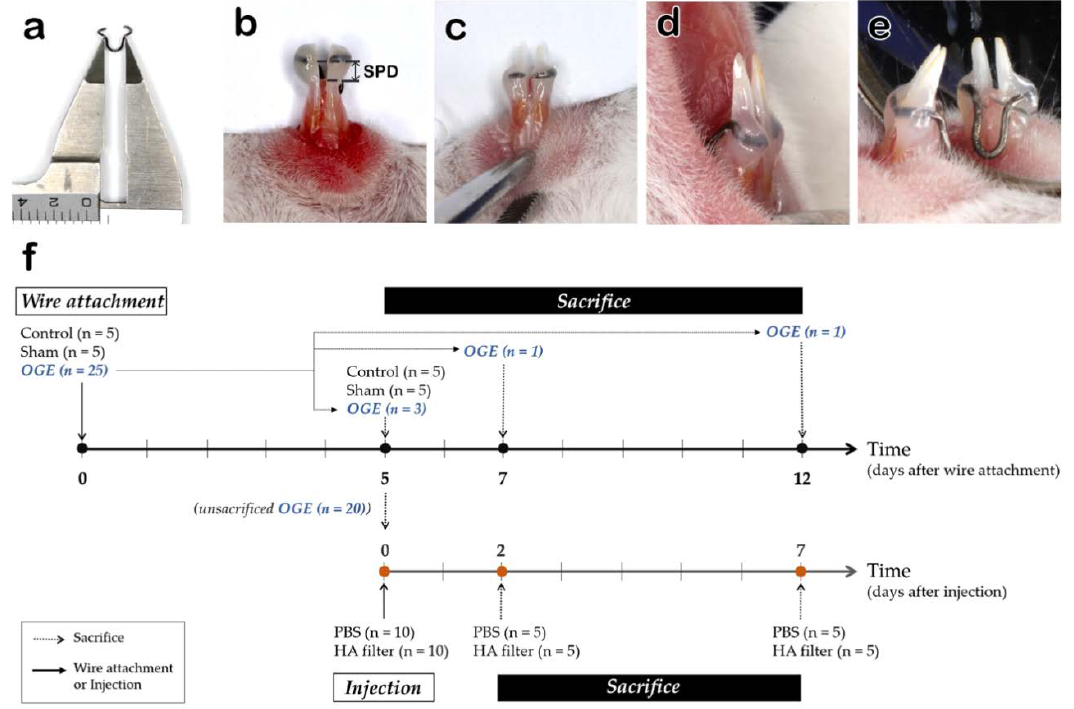
Figure 1. Reproduction of the open gingival embrasure (OGE) model and experimental